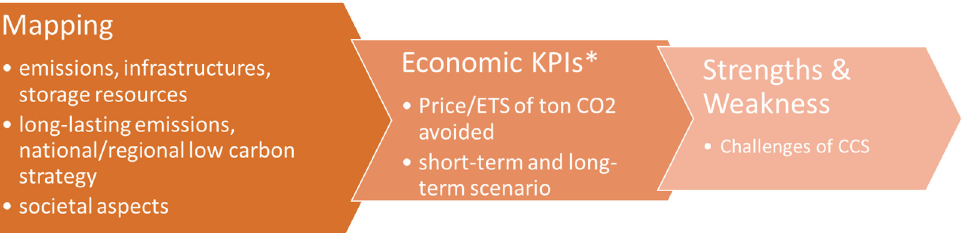
Figure 2. Schematic methodology chart illustrating the workflow to select potential areas to deploy a notable pilot-scale CCS project. * KPI: key performance